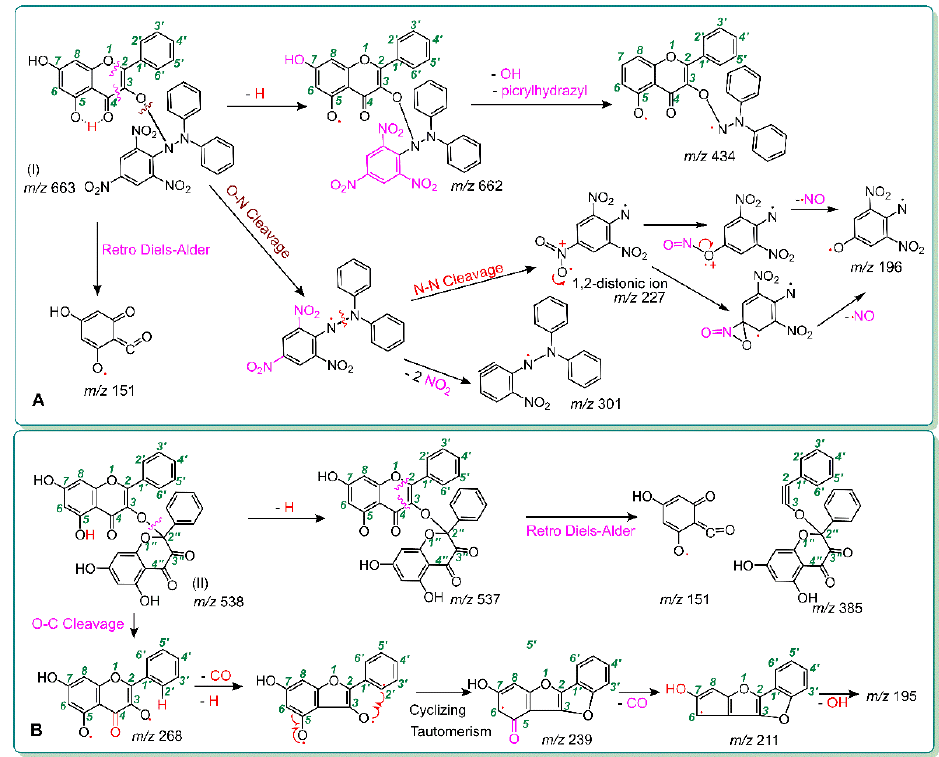
spectra of the galangin-galangin dimer; and ( J ) MS/MS spectra of the galangin-galangin dimer.